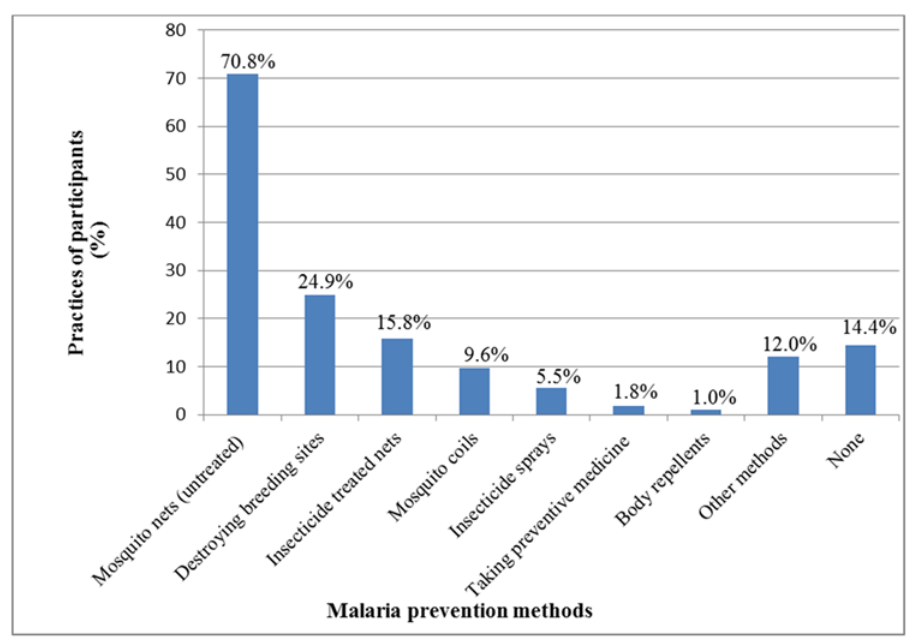
Fig 1. Malaria prevention methods used by